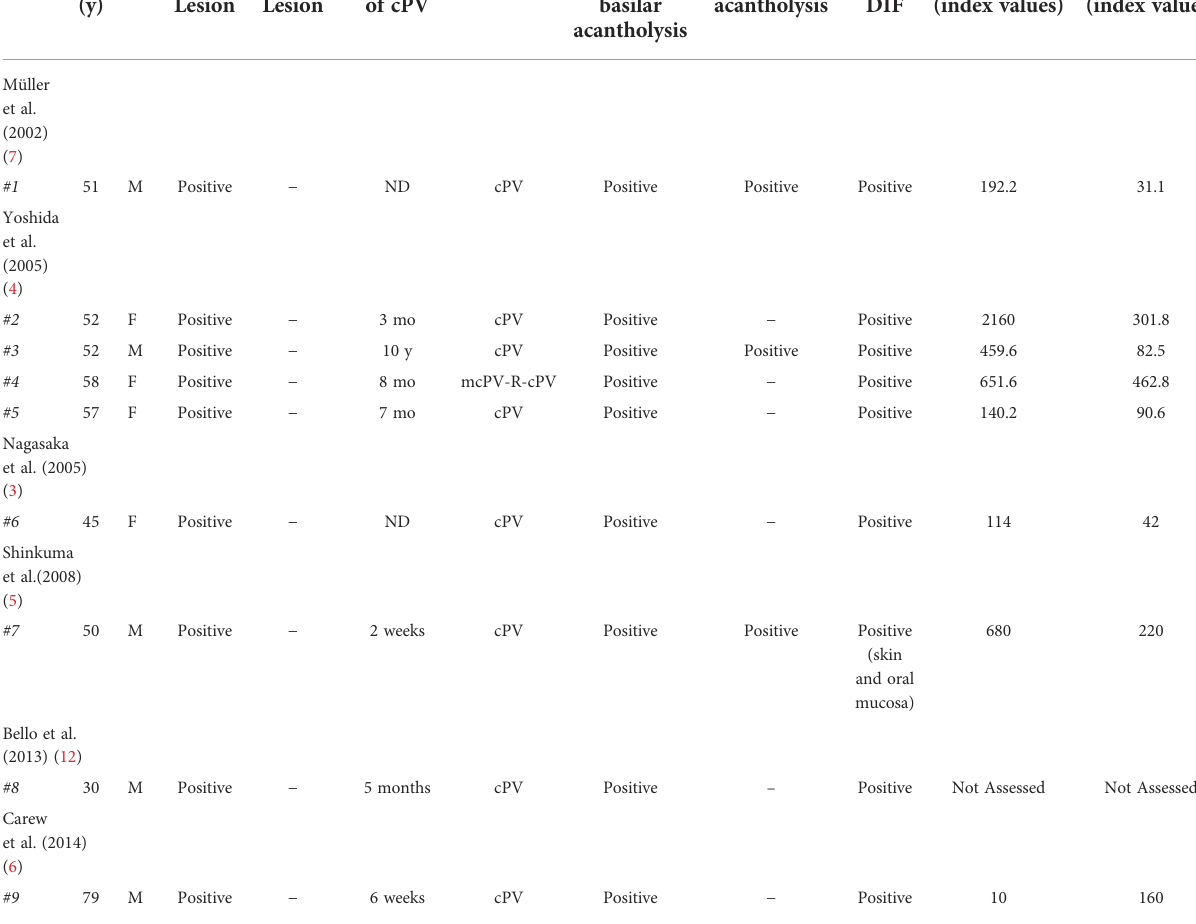
TABLE 2 Cases of cutaneous only PV reported in the